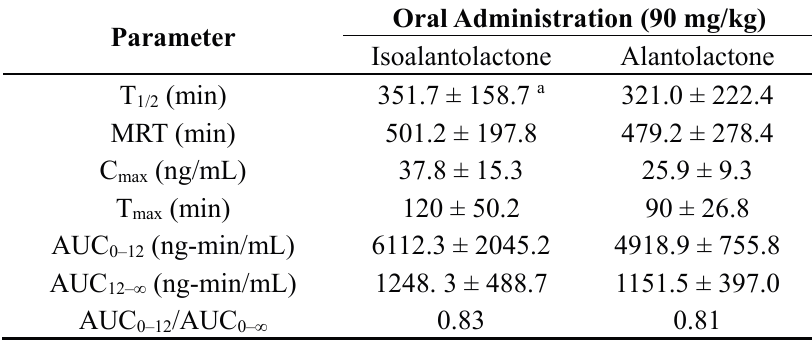
Table 2. Pharmacokinetic parameters of lactones in